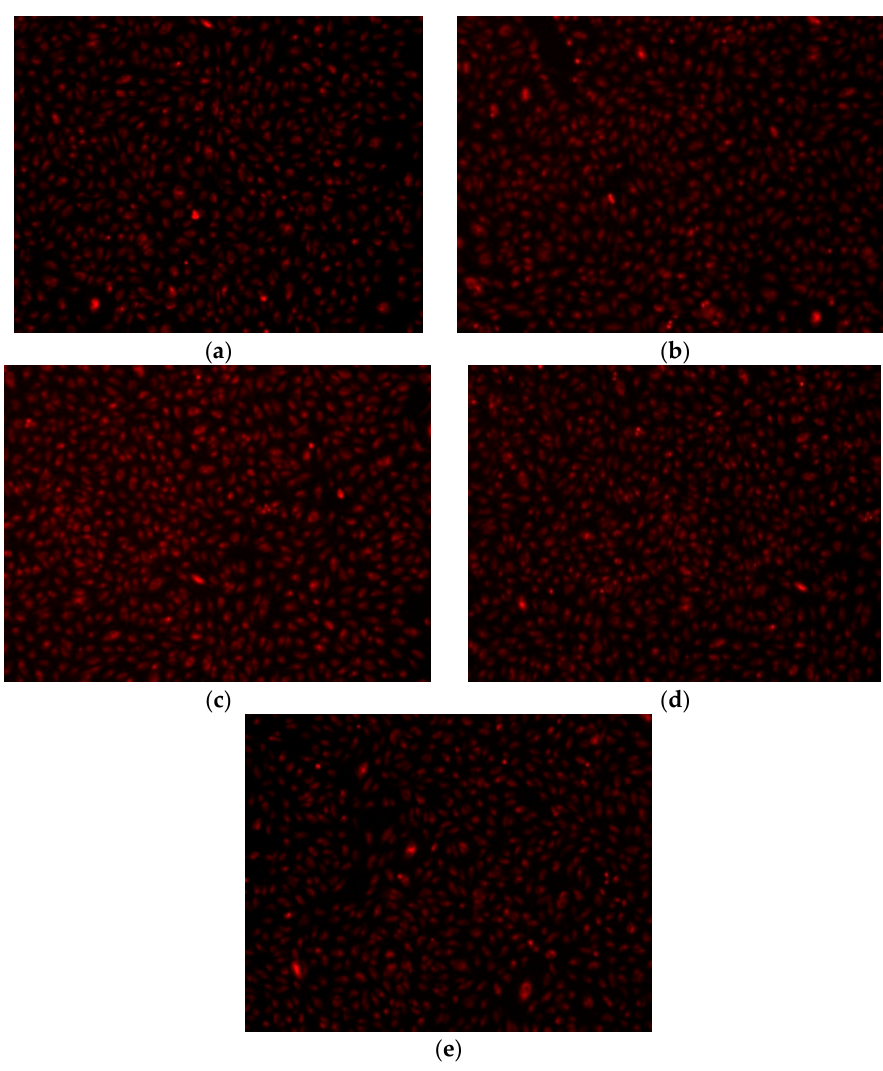
Figure 14. Fluorescence microscopic images of the endothelia cell monolayer in the presence of